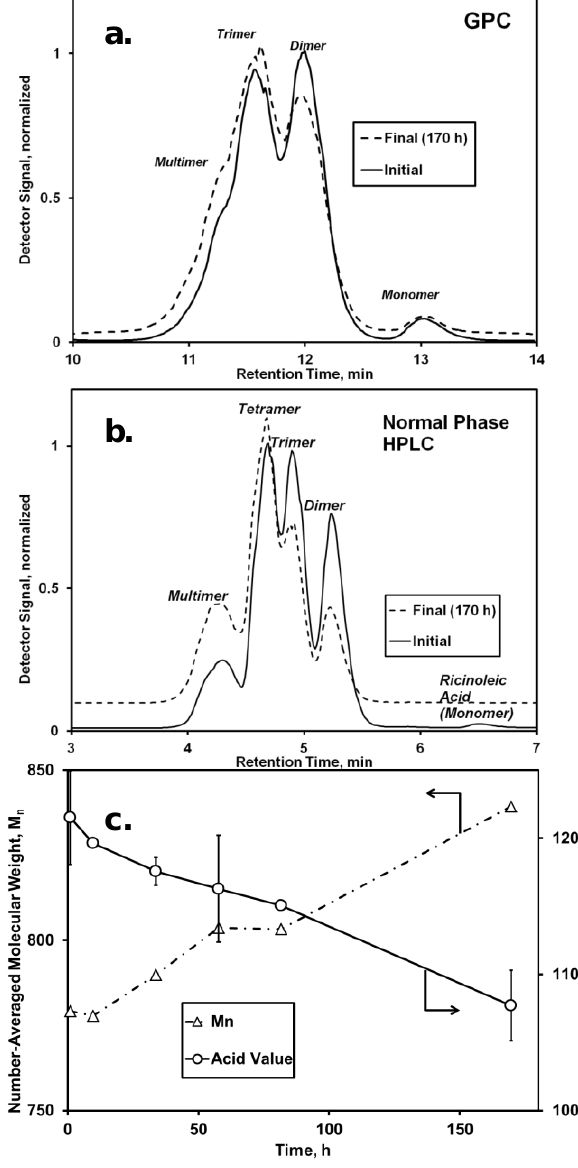
Figure 1. Analysis of the Candida antarctica lipase (CAL)-catalyzed esterification of oligo- ricinoleic acid and 10-undecenoic acid (Scheme I). Chromatograms: ( a ) gel permeation chromatography (GPC) and ( b ) normal phase HPLC of the reaction mixture and initial and final conditions (170 h); ( c ) Number-averaged molecular weight ( M obtained from GPC and acid value (AV) vs. time. Reaction conditions: